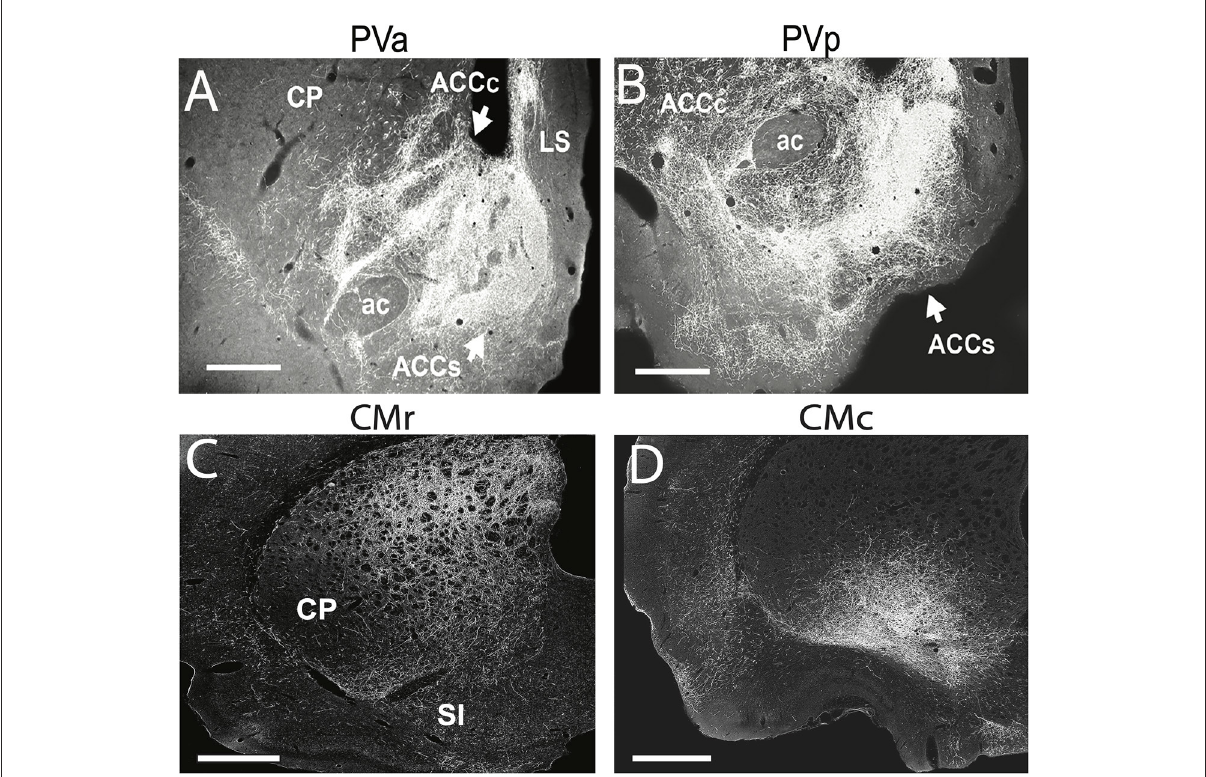
FIGURE6 (A,B) Darkfield micrographs of transverse sections through the basal forebrain showing patterns of labeling in the nucleus accumbens (ACC) produced by anterograde tracer injections into the anterior (PVa) (A) and posterior (PVp) (B) paraventricular nucleus of thalamus of the rat. (A) Note the massive terminal labeling in the shell (ACCs) and core (ACCc) of ACC produced by a PVa injection. (B) Note the massive terminal labeling in the shell of ACC but less dense labeling in the core of AAC produced by the PVp injection. (C,D) Darkfield micrographs of transverse sections through the dorsal striatum (CP) depicting patterns of labeling produced by anterograde tracer injections in the rostral (CMr) (C) and caudal (CMc) (D) central medial nucleus (CM) of the thalamus of the rat. Note the pronounced terminal labeling in the dorsomedial quadrant of CP following the injection in CMr (C) , compared with the dense labeling confined to the ventrolateral sector of CP following the injection in CMc (D) . ac, anterior commissure; LS, lateral septum; SI, substantia innominata. Scale bar for (A,B,D) = 500 µ m; for (C) = 750 µ m. Modified from Vertes and Hoover (2008) and Vertes et al.